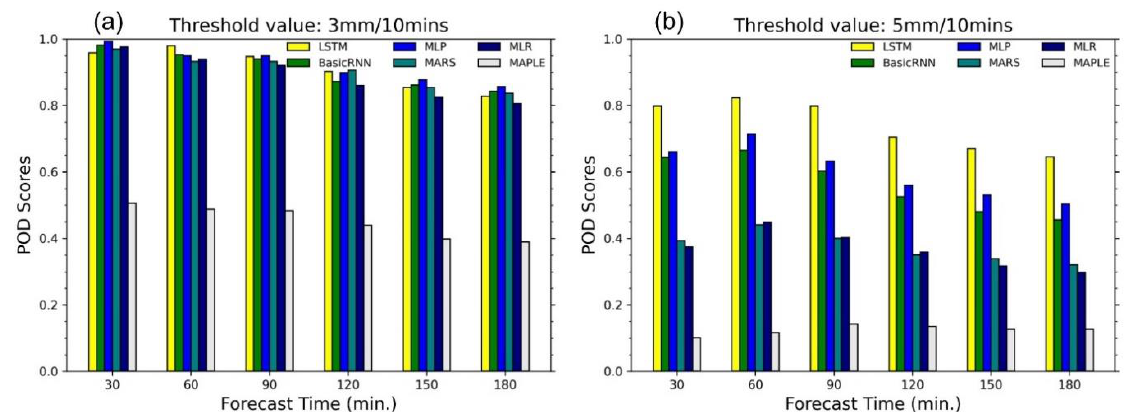
Figure 10. Probability of detection ( POD ) scores of the data-driven models and the MAPLE system with two thresholds in the five events. ( a ): POD scores with 3 mm/10 min threshold; ( b ): POD scores with 5 mm/10 min threshold.